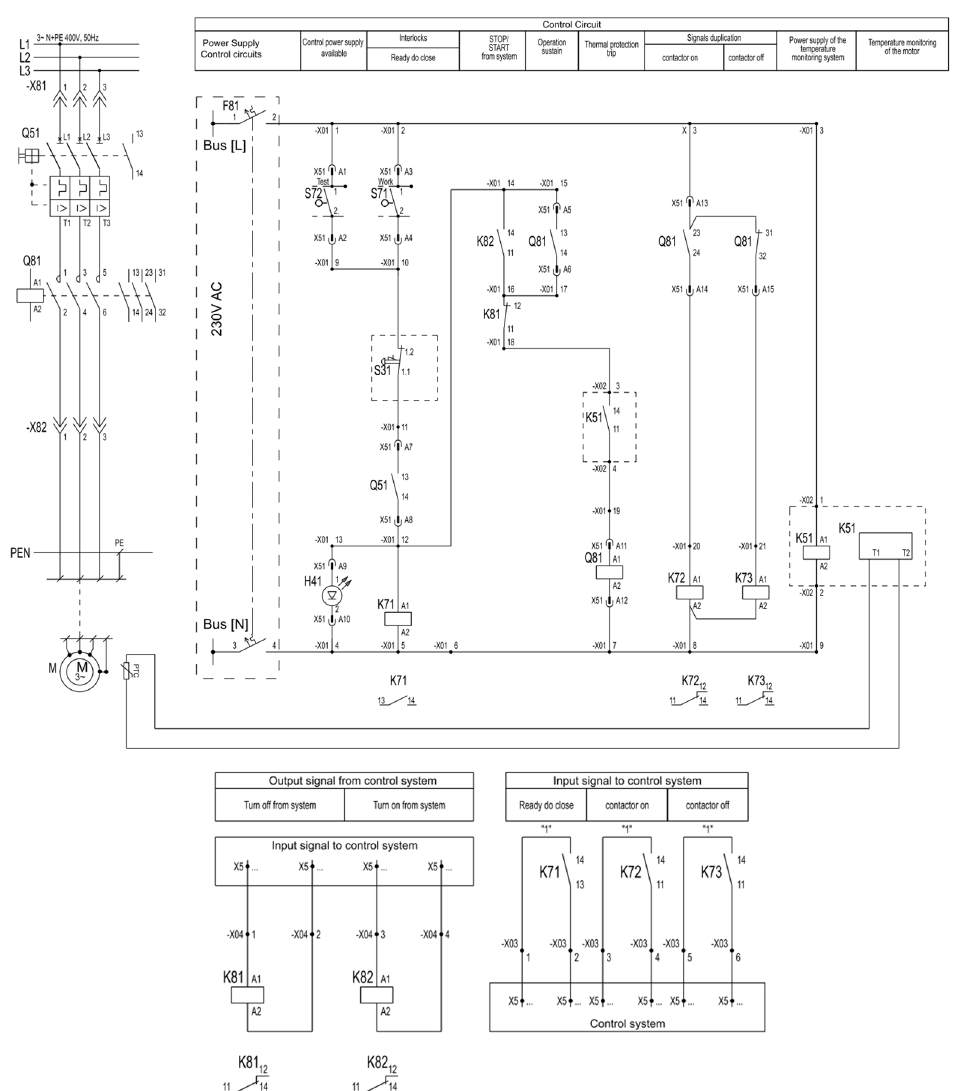
Figure 9. Power supply and control system with the use of classic control solutions based on relays with thermal protection.